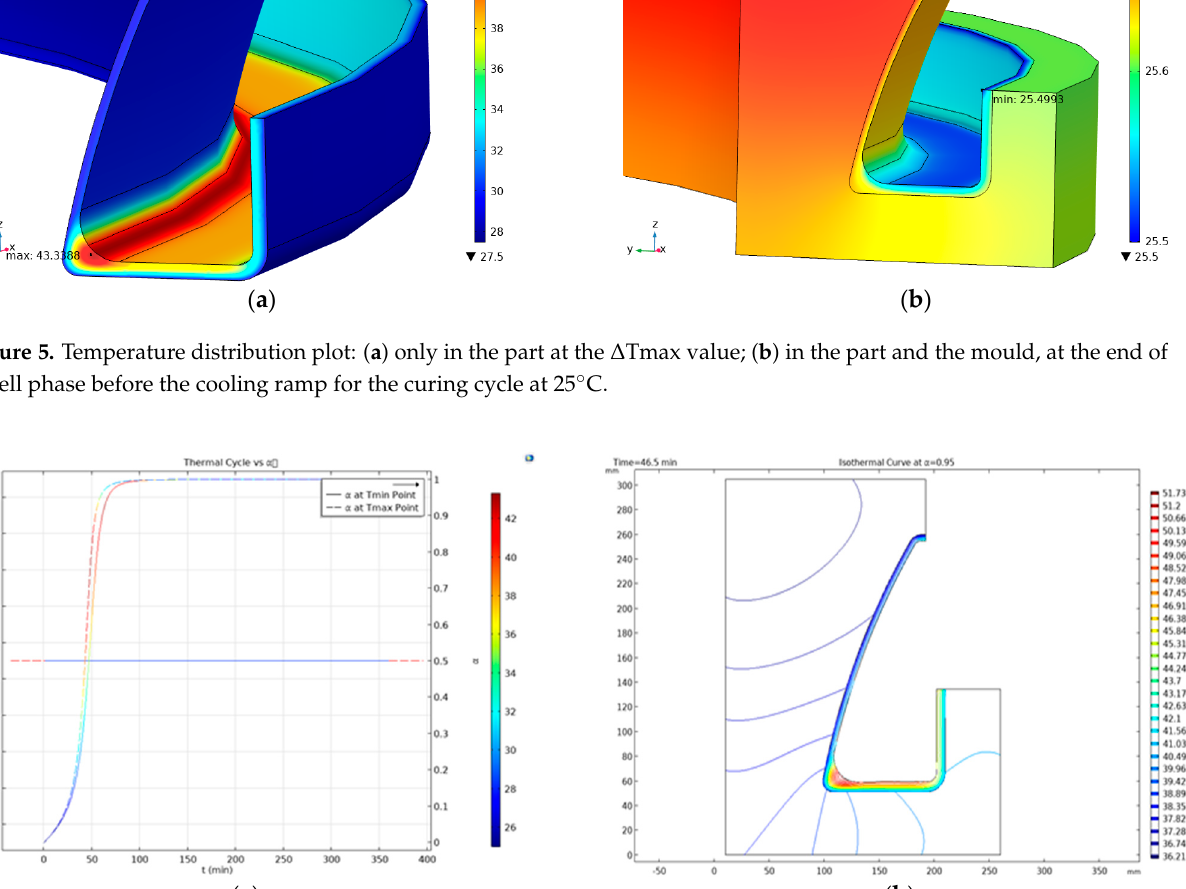
Figure 6. ( a )Thermal Cycle vs. α (DoP) for the curing cycle at 25 °C; ( b ) plot of the isothermal curves inside the component. The temperature distributions within the mould (Figure 7) at the end of the dwell highlight an increase of the thermal gradient as the dwell temperature increased, since the slow heat transfer did not ensure that the mould reached the environment temperature for the considered thermal cycle.